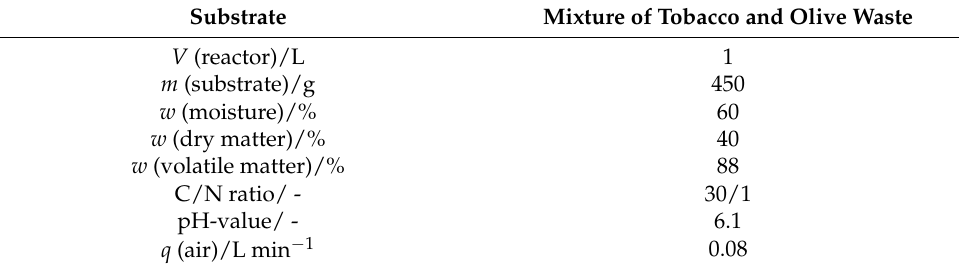
Table 2. The initial conditions of composting process in experiments P1, P2 and